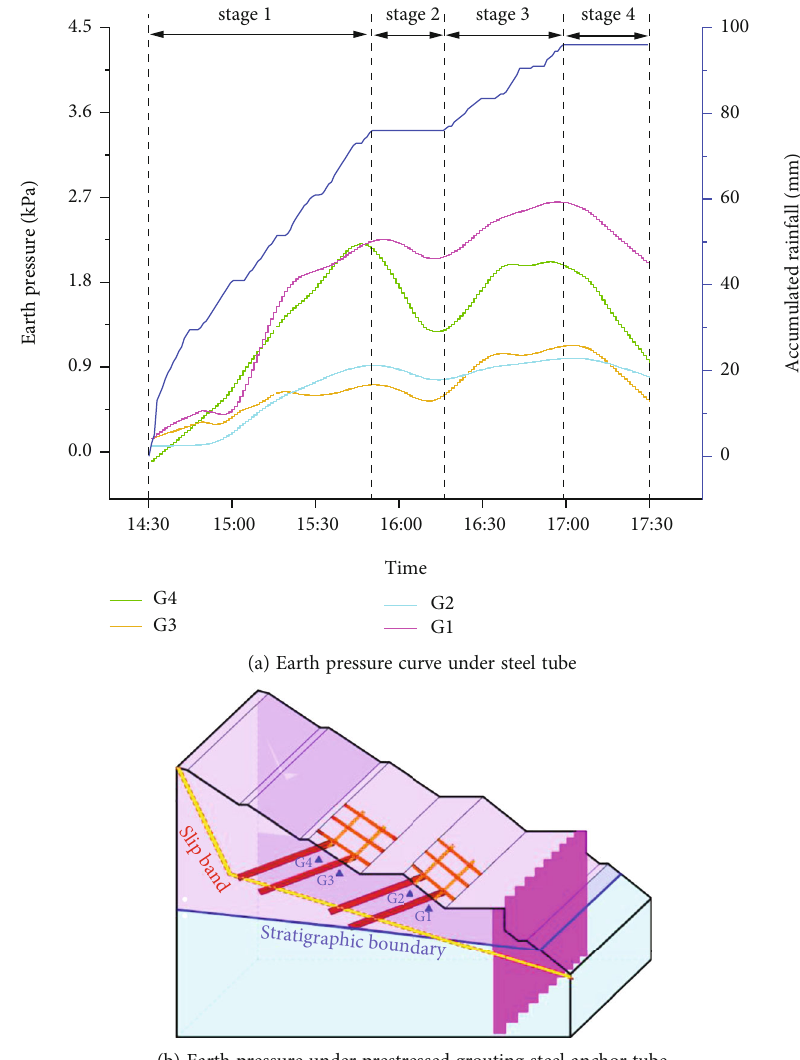
Figure 8: Earth pressure curve under prestressed grouting steel anchor